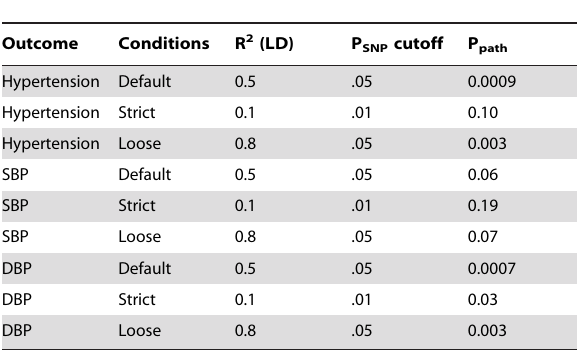
Table 4. Varying R 2 and P SNP cutoffs for the ADRA1